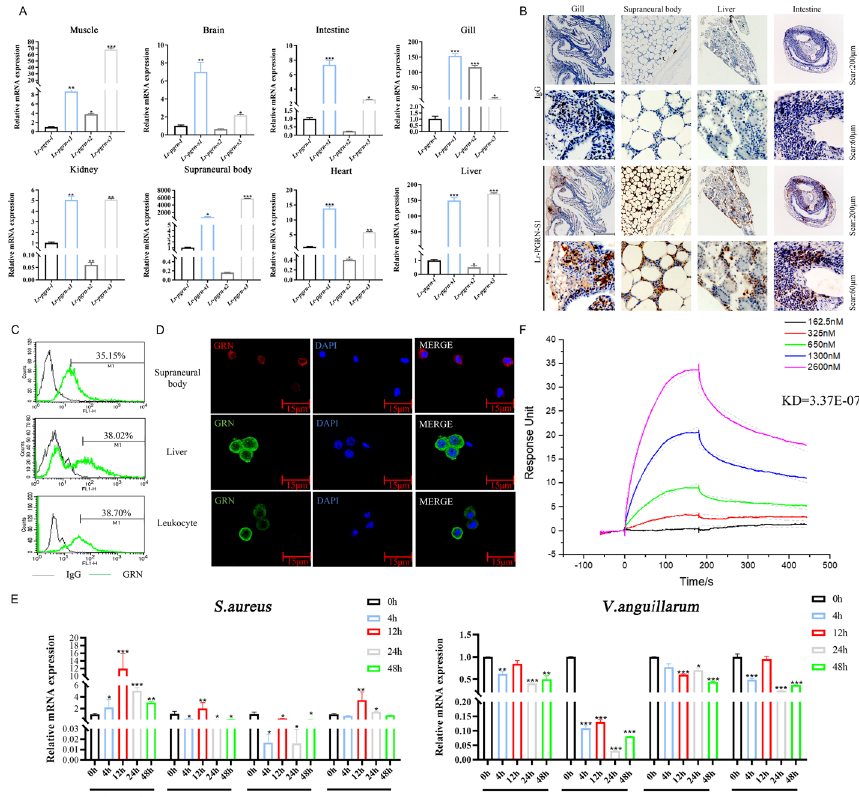
Fig. 2 Expression of Lr-pgrn genes in normal lamprey tissue after pathogen stimulation. A The expression of Lr-pgrn genes in the brain, kidney, heart, and other lamprey tissues was measured with qRT-PCR. B The distribution of Lr-PGRN-S1 in the gill, supraneural body, kidney, and intestine tissues was measured by immunohistochemistry. The two expressions were observed in a 10 and 40 magnification field of view, × × respectively. Normal rabbit IgG was used as negative control. C Lr-PGRN-S1 protein expression in lamprey cells by FACS analysis. Representative contour plots were gated on Lr-PGRN-S1-positive cells (green line). The black line indicates cells with the IgG isotype control. D Immunofluorescence detection of the cellular location of Lr-PGRN-S1. Light blue: nucleus; light green and red: Lr-PGRN-S1. E The expression level of Lr-pgrn genes in lampreys after S. aureus and V. anguillarum stimulation during 0, 4, 12, 24, and 48 h as determined by qRT-PCR and normalized to gapdh expression. F Interaction of rLr-PGRN-S1 with rL-TNFR as determined by BIAcore analysis. The KD values were measured using the BIA evaluation version 3.0 software. The data are presented as mean standard deviation (SD) based on three independent samples with three replicates ± per sample. Probabilities of statistical differences between experimental groups in all bar graphs were determined by Student’s t -test. * P < 0.05, ** P < 0.001, *** P <